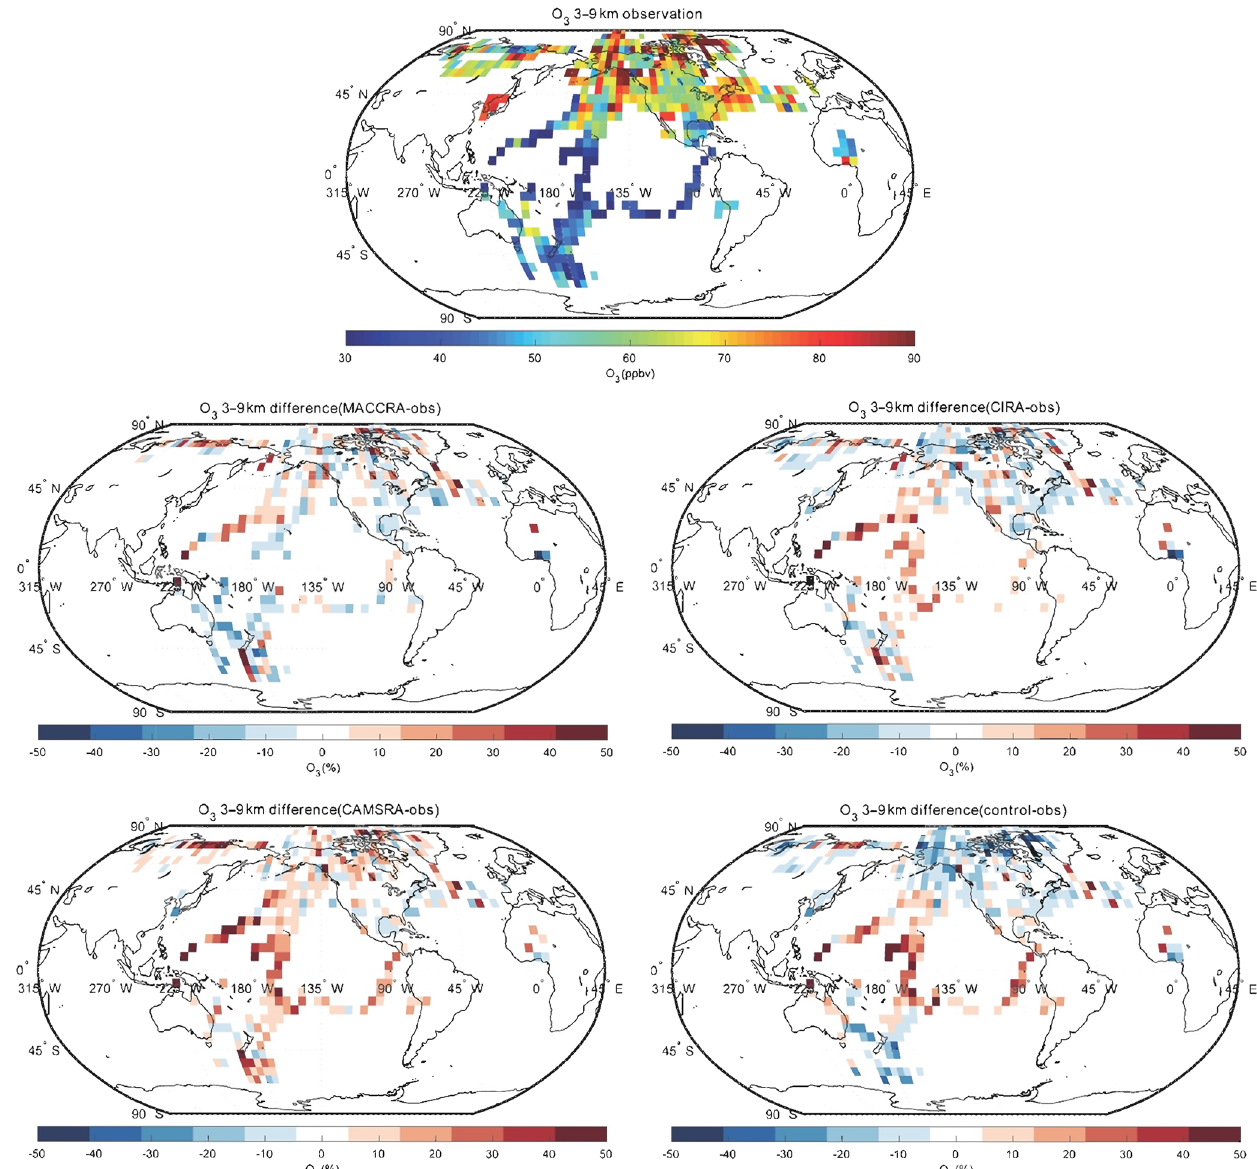
Figure 3. Same as Fig. 2, but for the altitude bin of